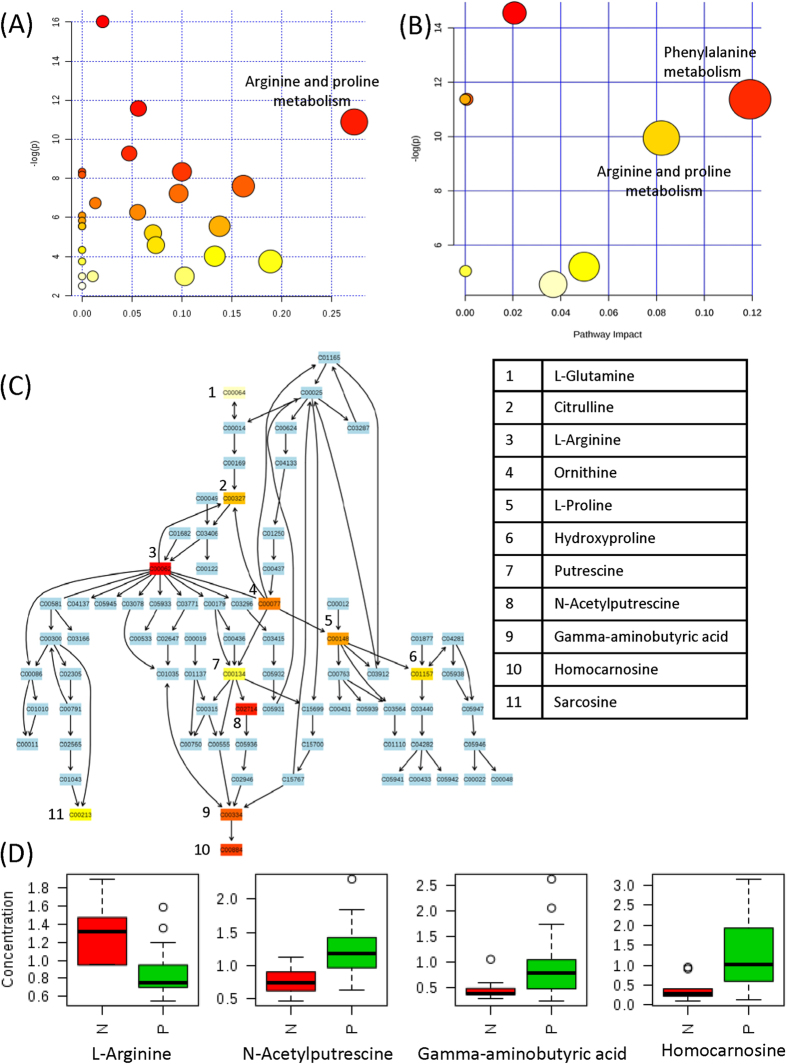
(A) Overview of pathway analysis based on selected CSF metabolites. (B) Overview of pathway analysis based on selected serum metabolites. Each circle represents a matched pathway. The node color and radius were determined by p-value and pathway impact value, respectively. A detailed summary of MetPA results can be found in Supplemental Table T2. (C) Schematic illustration of the arginine and proline metabolism. Compounds were represented by their KEGG compound ID. Matched compounds were shown in varied heat map colors based on their p-values, with red indicates lower p-value. The names of the eleven metabolites detected in this study were listed in the table on the right. The peak ratios of four most significantly altered metabolites in CSF were shown below as box-and-whisker plots (D). N: non-injured controls; P: injured patients.